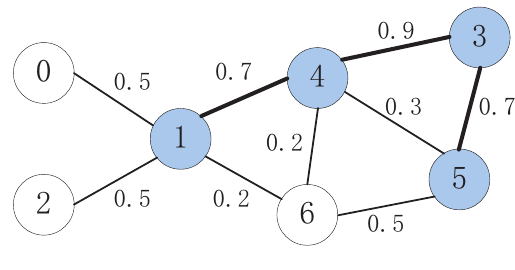
Figure 4. The final